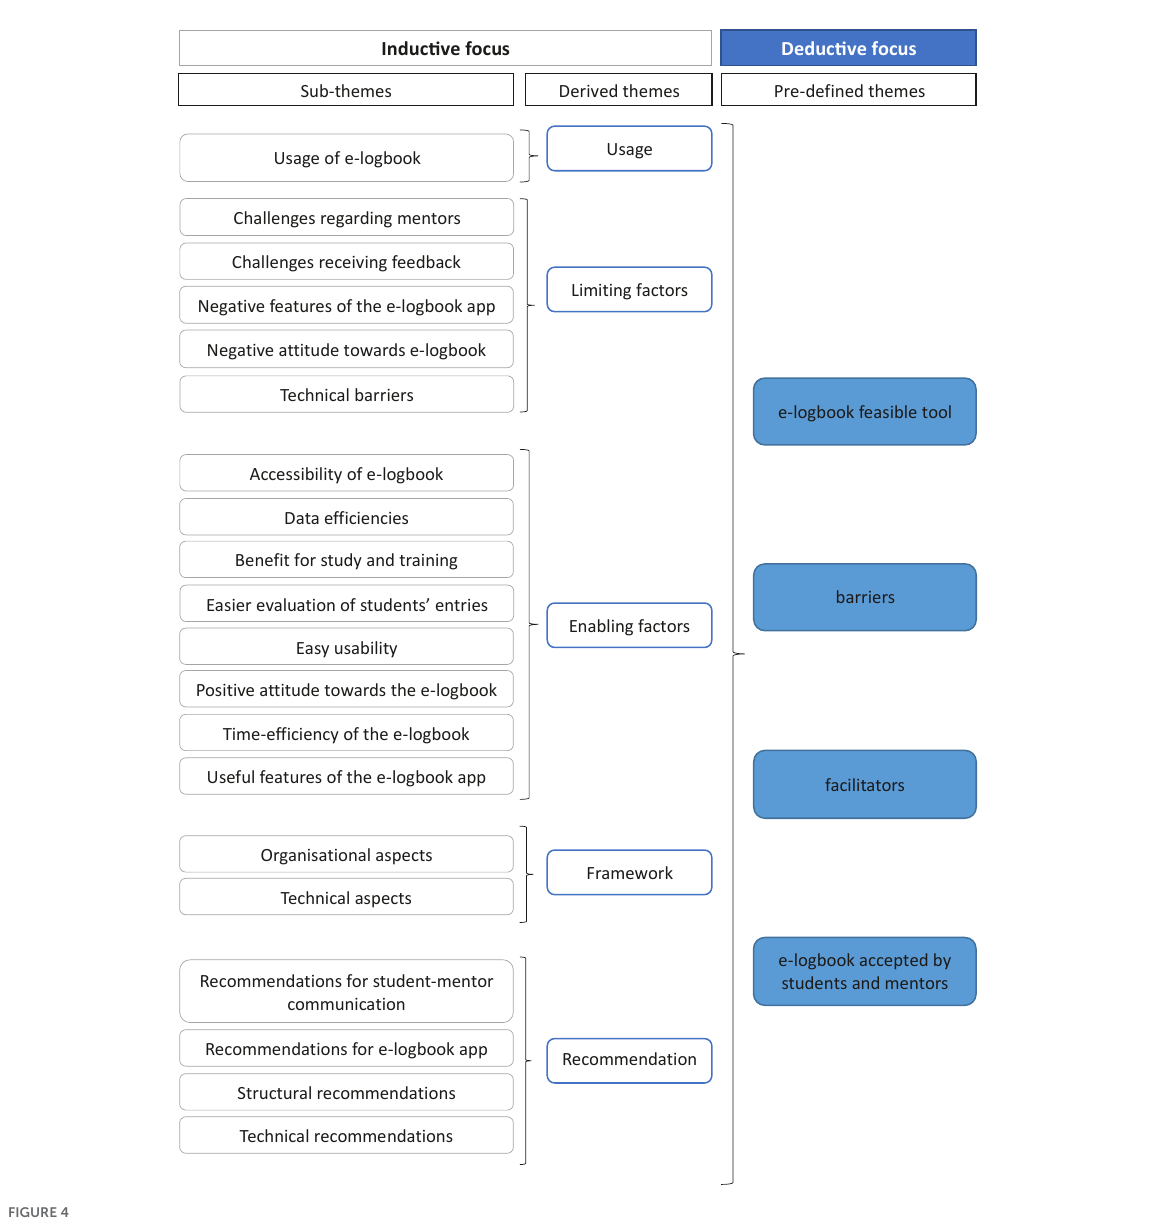
S1: 78–82. Interviews were indicated as I1, I2, etc.